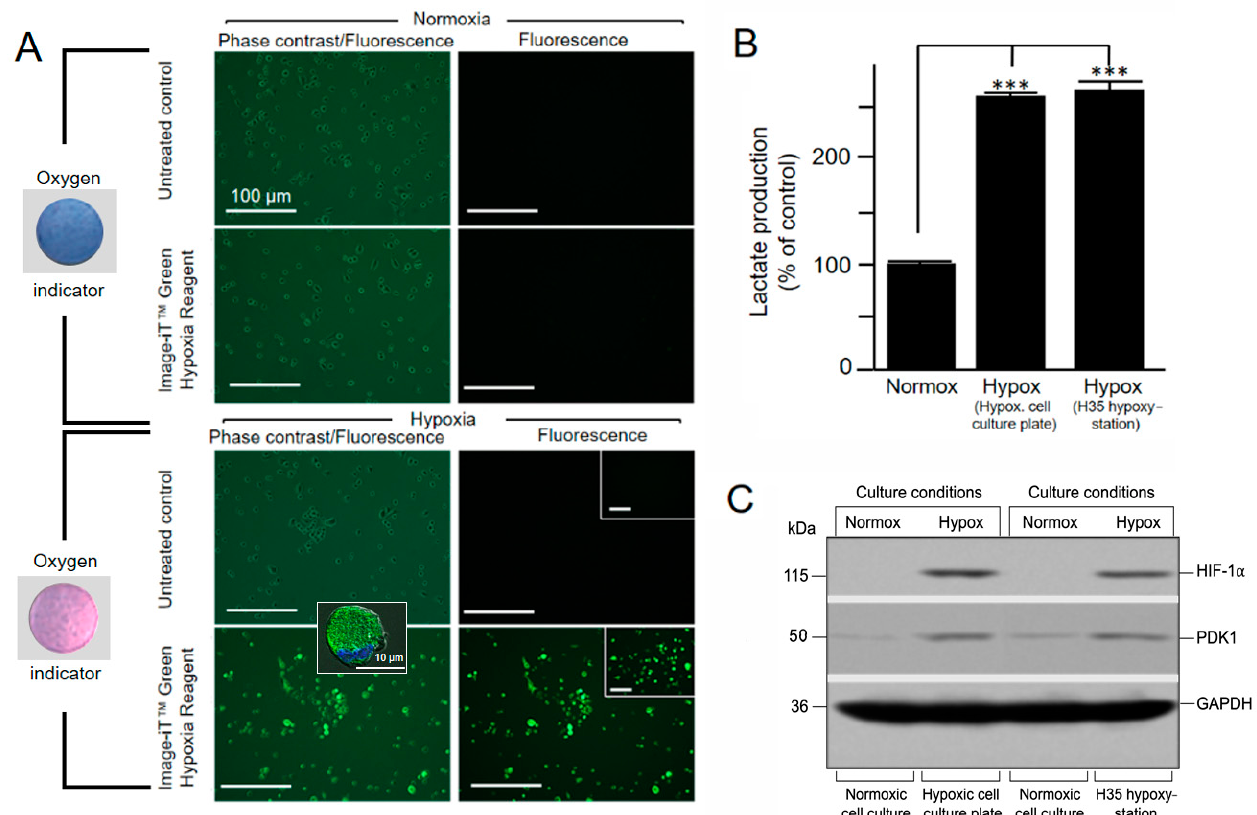
Figure 2. Cultivation of JAWS II cells under hypoxic cell culture conditions. ( A ) The microscopic images show the analysis of JAWS II cells after 5 h of cultivation under hypoxic cell culture conditions in a sealed hypoxic cell culture plate. Untreated and Image-iT Green Hypoxia-treated cells under norm- (top) and hypoxic (bottom) conditions are shown in phase contrast and under fluorescence (10× magnification). The corresponding color of the oxygen indicator is shown on the left. The lower left image insert shows a green fluorescent hypoxic cell taken with a Zeiss ApoTome fluorescence microscope using a 63× oil immersion objective (the cellular nucleus was costained with DAPI, blue). The inserts in the two lower right images show corresponding control and Image-iT Green Hypoxia-stained cells cultivated in a commercial hypoxystation. ( B ) JAWS II cells were cultured under norm-, and hypoxic conditions in either the hypoxic cell culture plate or a hypoxystation, as indicated, for 48 h after which cellular lactate was measured with an L-lactate assay kit (*** p < 0.001 versus controls; n = 3). ( C ) Immunoblot analysis of HIF-1 α stability and PDK1 induction in JAWS II cells under norm- and hypoxic cell culture conditions after 72 h of cultivation in the hypoxic cell culture plate (second lane) and a commercial hypoxystation (fourth lane). GAPDH was included as a sample loading control.